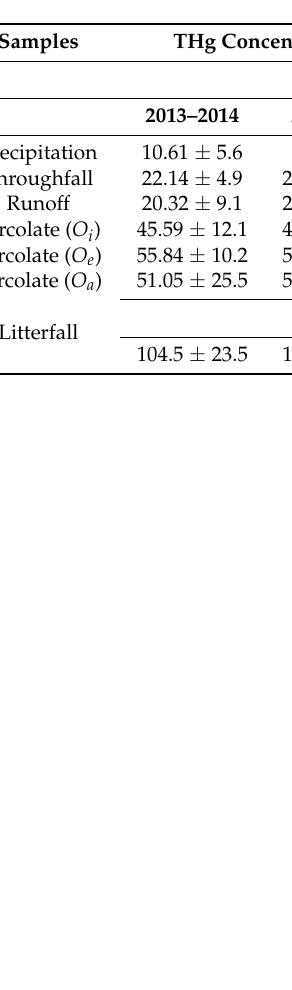
Figure 3. MeHg concentrations and fluxes in the precipitation and throughfall collected in the study forest stand from 2013 to 2015.